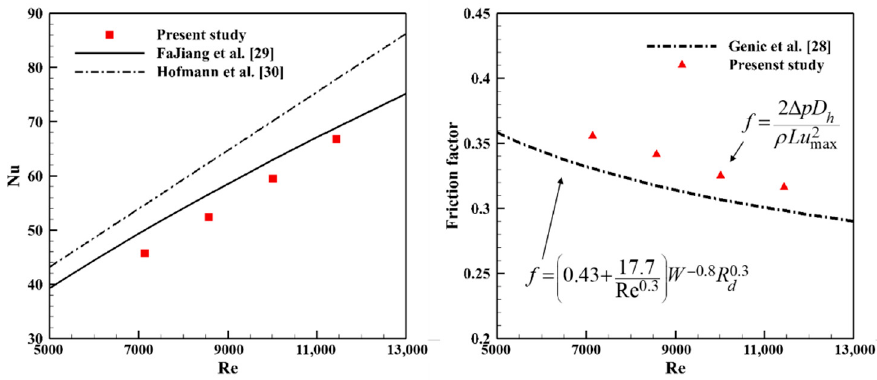
Figure 4. Comparison of Nu and friction factor between numerical predictions and correlations. ( Left ): Nusselt number; ( Right ): Friction factor.